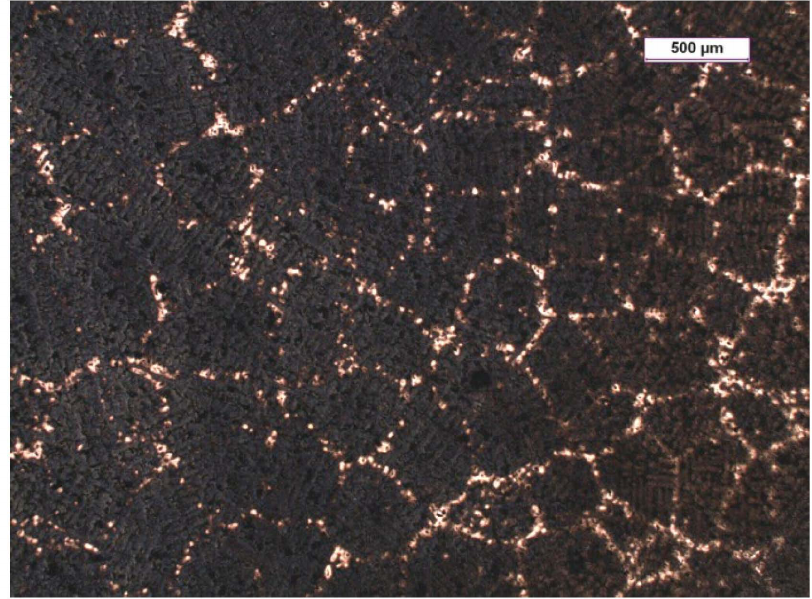
Figure 2. Example of grey cast iron microstructure consisting of eutectic grains revealed on surface of metallographic specimen after etching with Stead’s